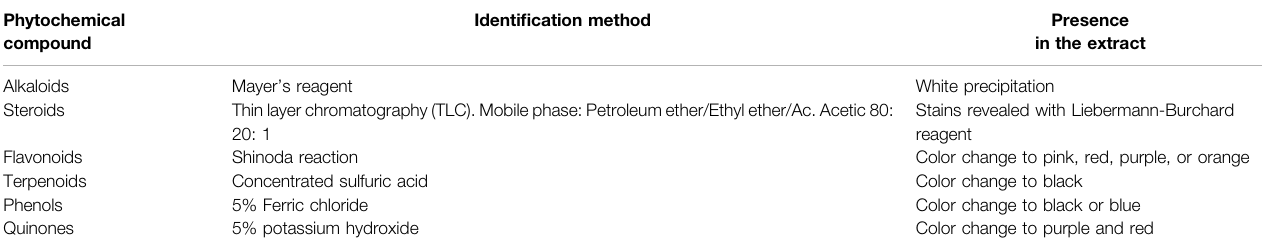
TABLE 1 | Methods for the qualitative identi fi cation of the phytochemicals of ethanolic extract and polar and nonpolar fractions of Lophocereus schottii . Phytochemical